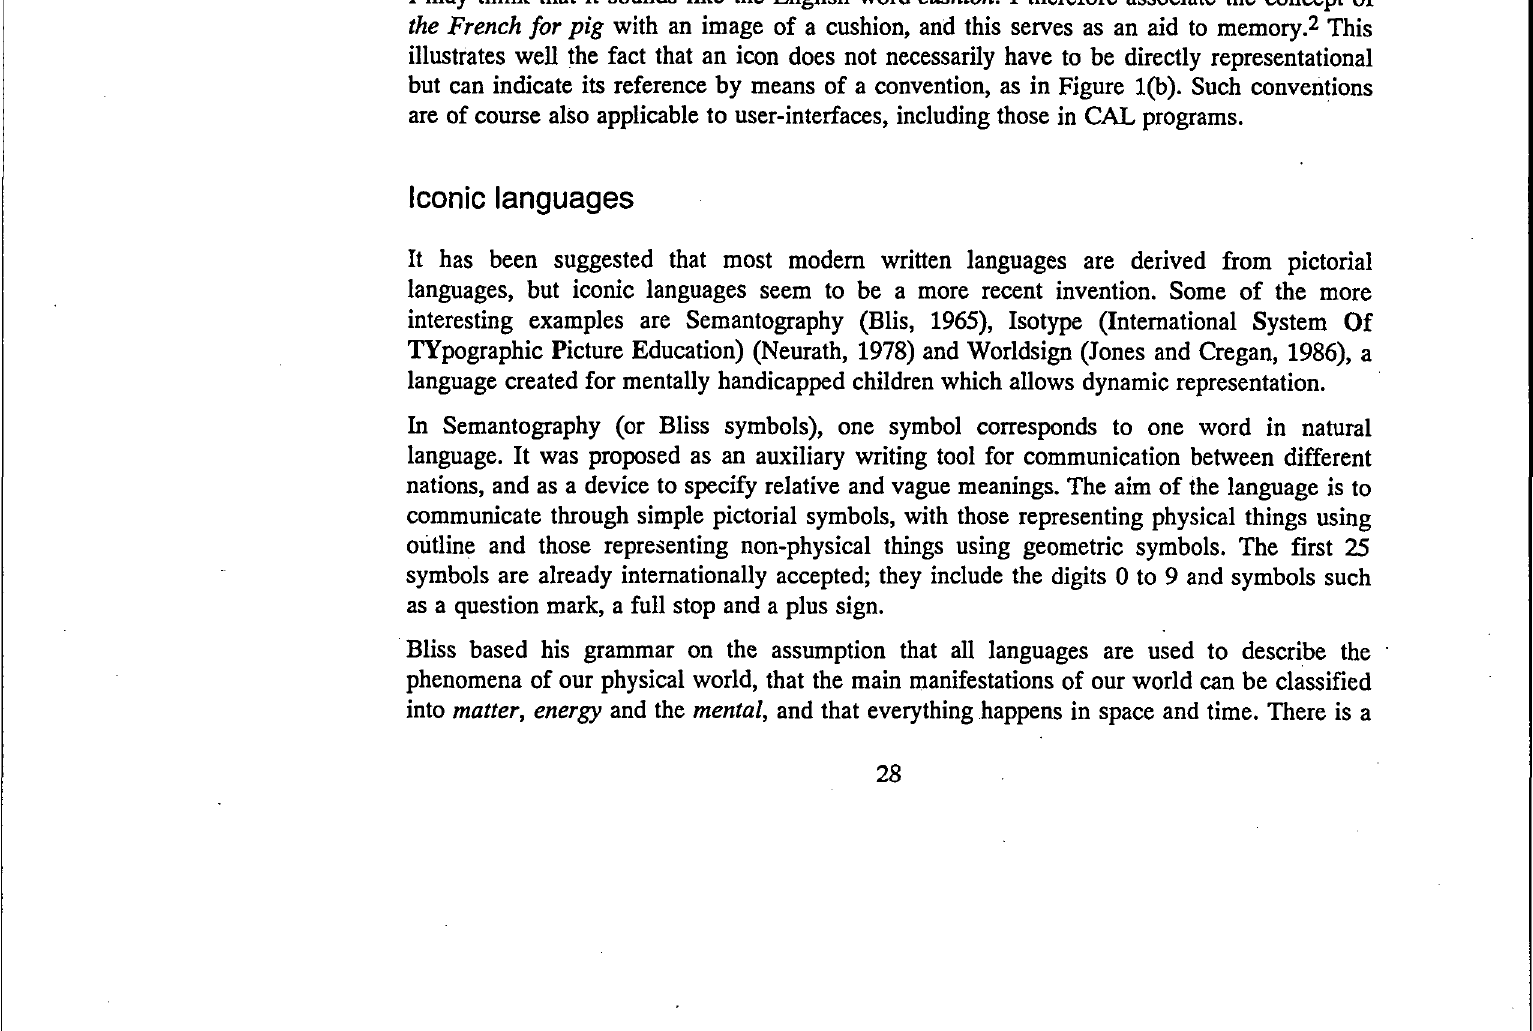
Figure 2: A hump-backed bridge r e m e m b er b e c a u se il is a well-known aid to memory to associate the thing to be remembered with a simple object to which it has a defined relationship. For example, to remember the French word for pig